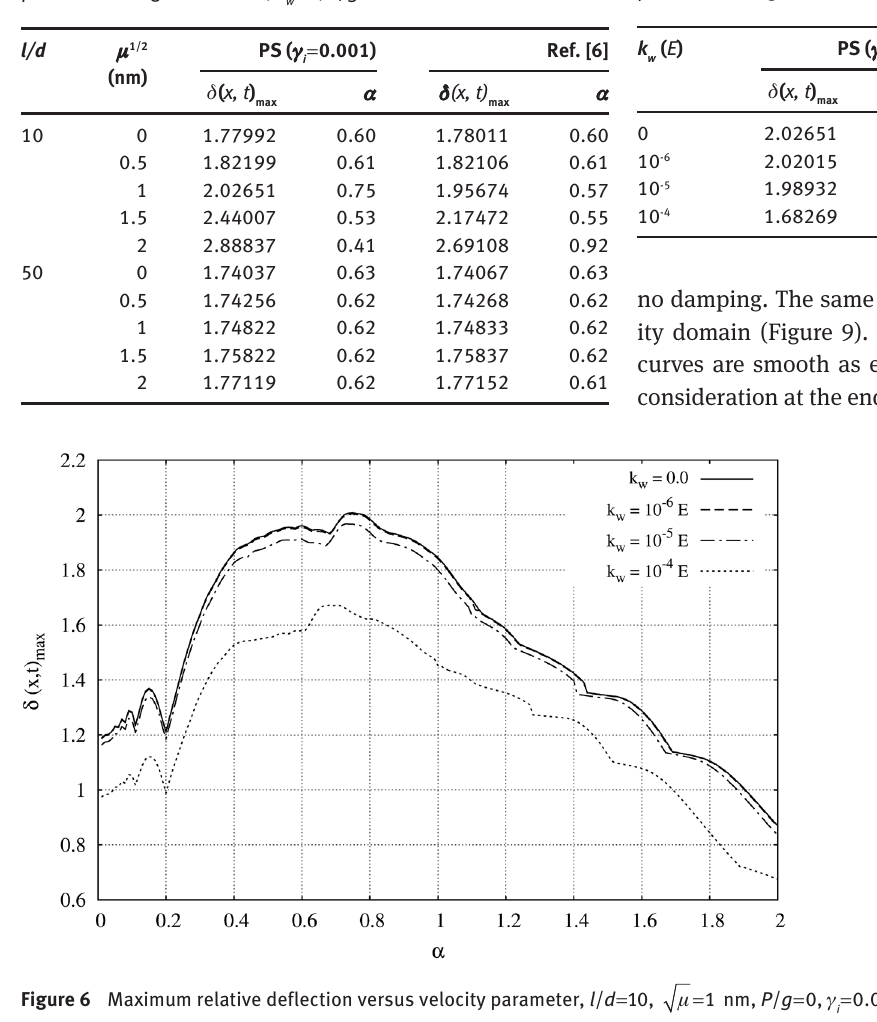
Figure 6 Maximum relative deflection versus velocity parameter, l / d = 10, µ = 1 nm, P / g = 0, γ